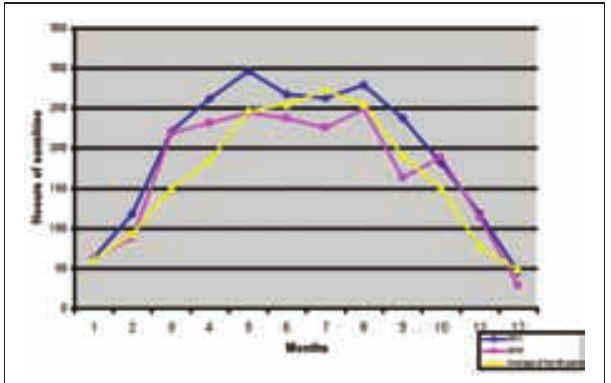
Figure 1c: Monthly insolation hours in 2010 and in 2011, compared with the average of 49 previous